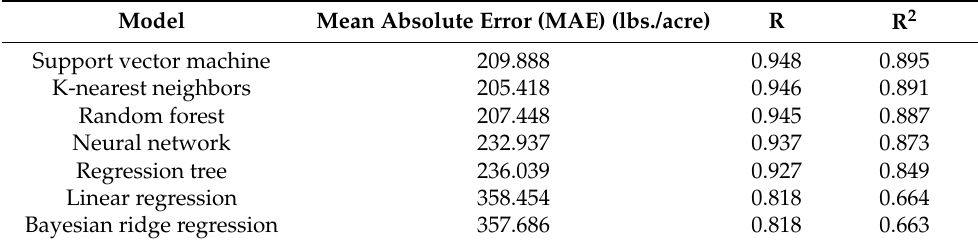
Figure 1. Performance of models with k features and all features made available for feature selection. The average R value of the models is shown. SelectKBest feature selection was used with K values from K = 3 to K = 11. Note that the average R value for Bayesian ridge regression and linear regression were much lower than any of the other models, so they were not shown here. Table 3. The average scores from training the models with all possible